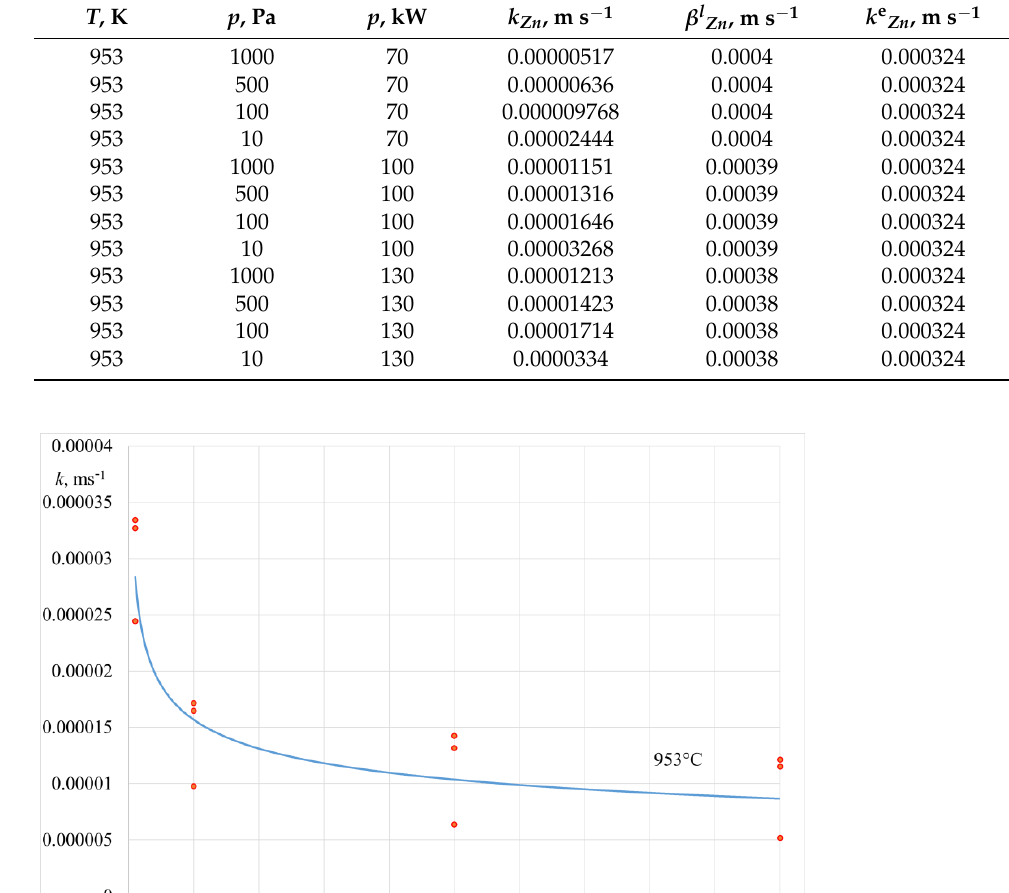
Zn vs. pressure (crucible induction furnace).